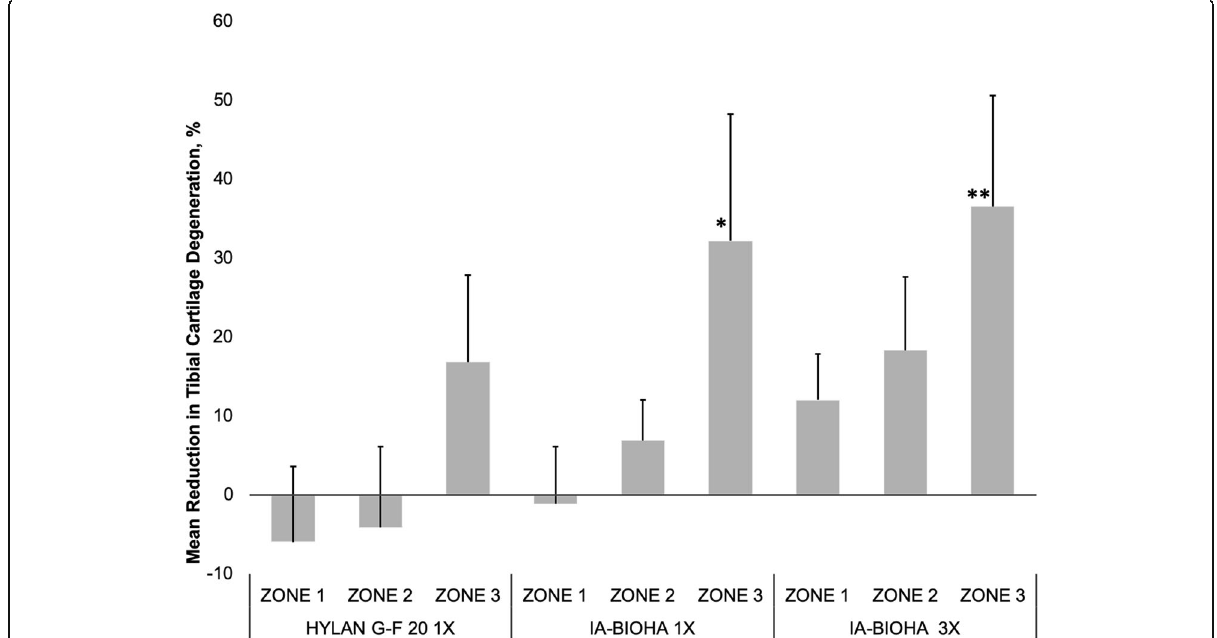
Fig. 3 Medial tibial collagen degeneration by tibial zone. The effect of IA-BioHA or IA-hylan G-F 20 on tibial collagen by tibial zone is presented as the percent change from the vehicle control animals. A positive number indicates the tibial collagen score was less than vehicle control and a negative number indicates the tibial collagen was greater than vehicle control. Error bars reflect 1 standard deviation. n =15/group. Different from vehicle control; * p =0.016, ** p =0.030